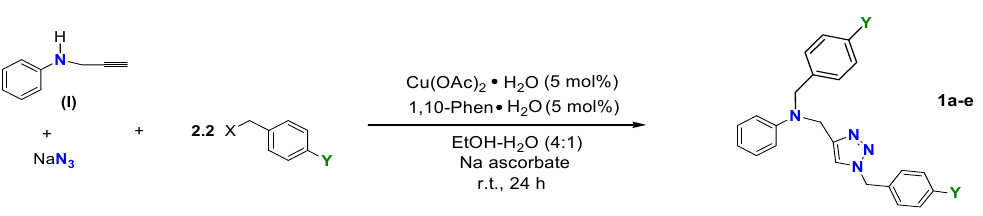
Table 2. Synthesis of bis-1,2,3-triazoles 1a – e